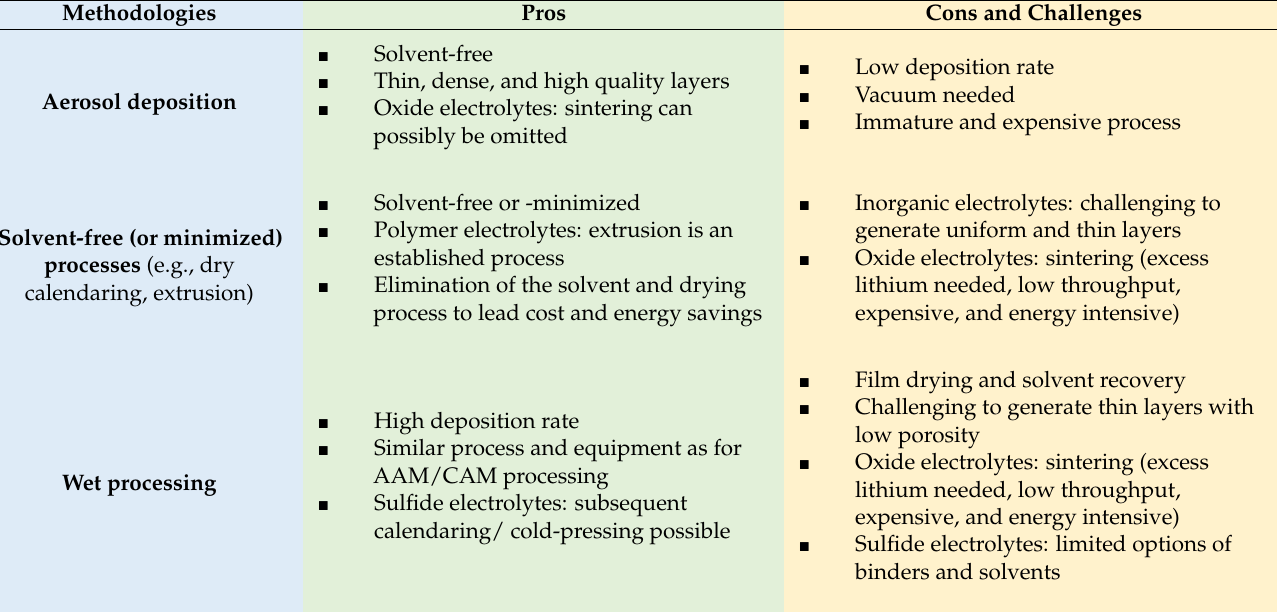
Table 3. Processing routes for solid electrolytes including their advantages and